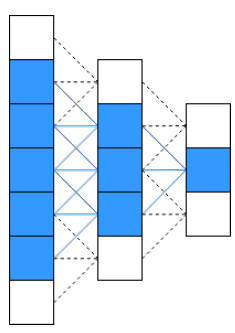
Figure 4. Receptive Field of Convolutional Neural